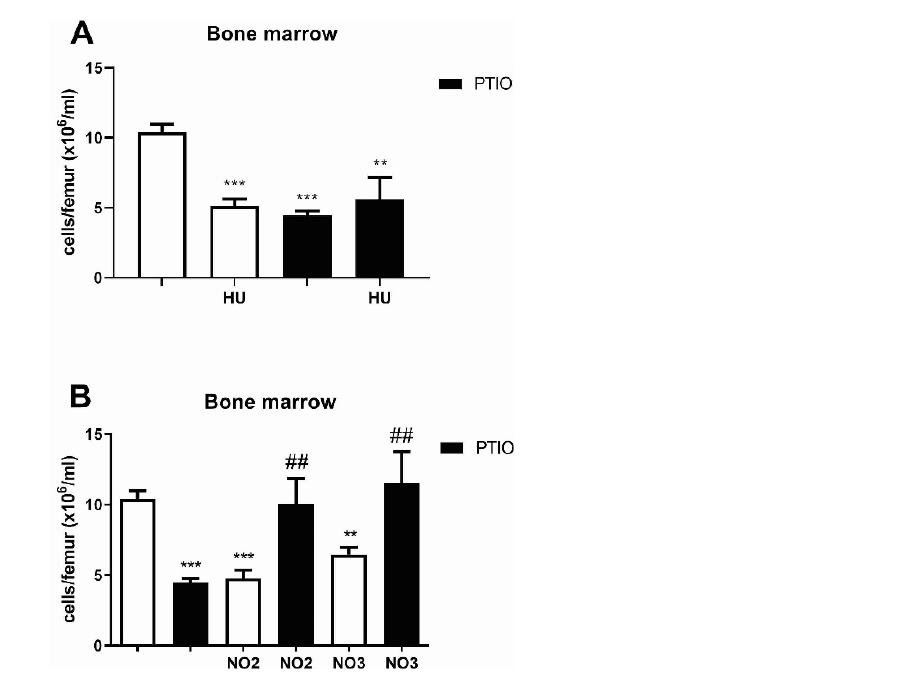
Figure 2. Quantity of bone marrow nucleated cells per femur of mice. After 7 days of in vivo treatment by hydroxyurea (HU) ( A ), sodium nitrite (NO 2 ) or sodium nitrate (NO 3 ) ( B ) with or without PTIO. Values are mean ± SEM ( n = 10). ** p < 0.01 and *** p < 0.001 vs. non-treated mice (Control); ## p < 0.01 vs. NO 2 or NO 3 treated only. Table 1. Hematologic parameters in peripheral blood and weight of treated mice [5].